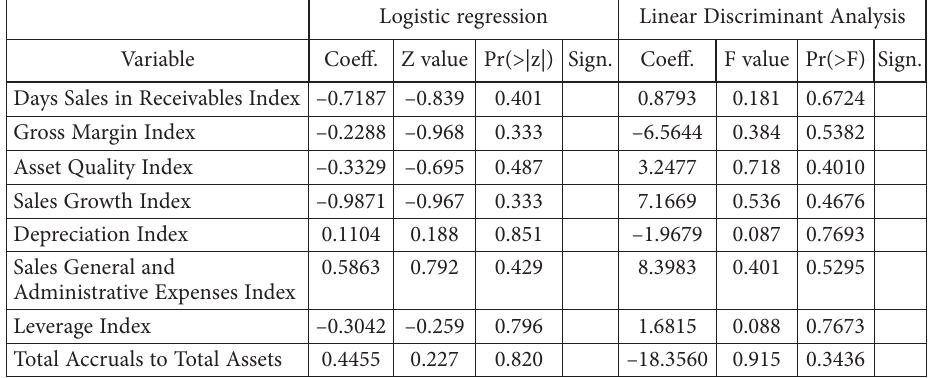
Table 5. Results of logistic regression and linear discriminant analysis for dataset A Logistic regression Linear Discriminant Analysis Variable Coeff. Z value Pr(>|z|)